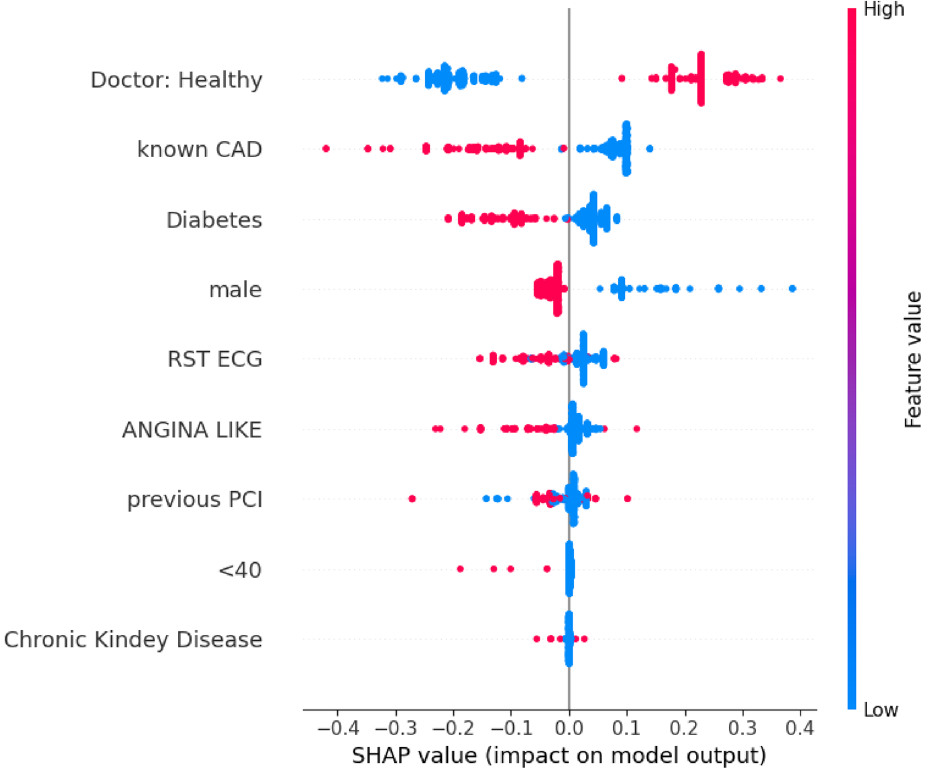
Figure 2. Summary plot illustrating the relative importance of each input feature in the prediction model, as represented by the SHAP values. Being a binary classification problem, feature values can either be ‘0’ or ‘1’, with value ‘1’ indicating the positive (e.g. male = 1, means the patient is male).